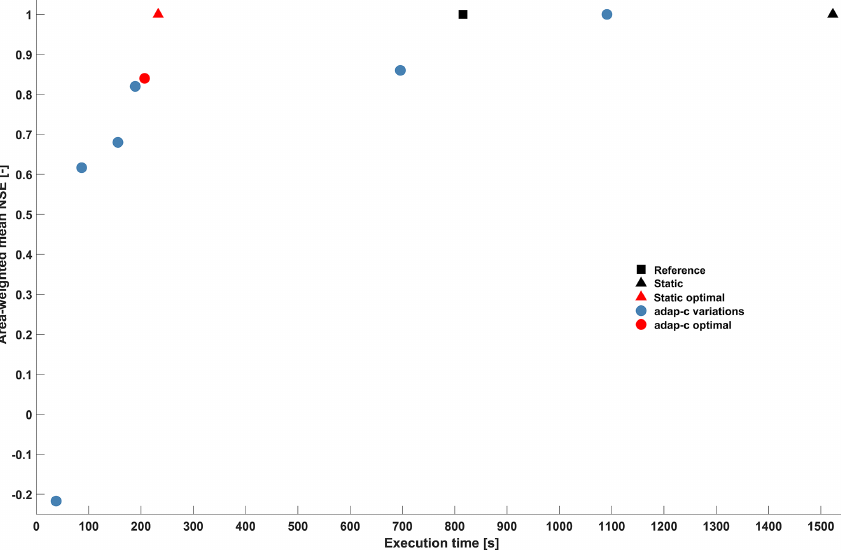
Figure 5. Performance of model runs with respect to effort, measured by execution time, and quality, measured by the mean Nash–Sutcliffe efficiency of subcatchment runoff q cat , out . Reference – full resolution, with no adaptive clustering overhead; static – full resolution, with adaptive clustering overhead; static optimal – time-invariant optimal clustering, with clusters shown in Table 2; adap-c variations – adaptive clustering, with various parameter settings; and adap-c optimal – optimal adaptive clustering, with parameters shown in Table